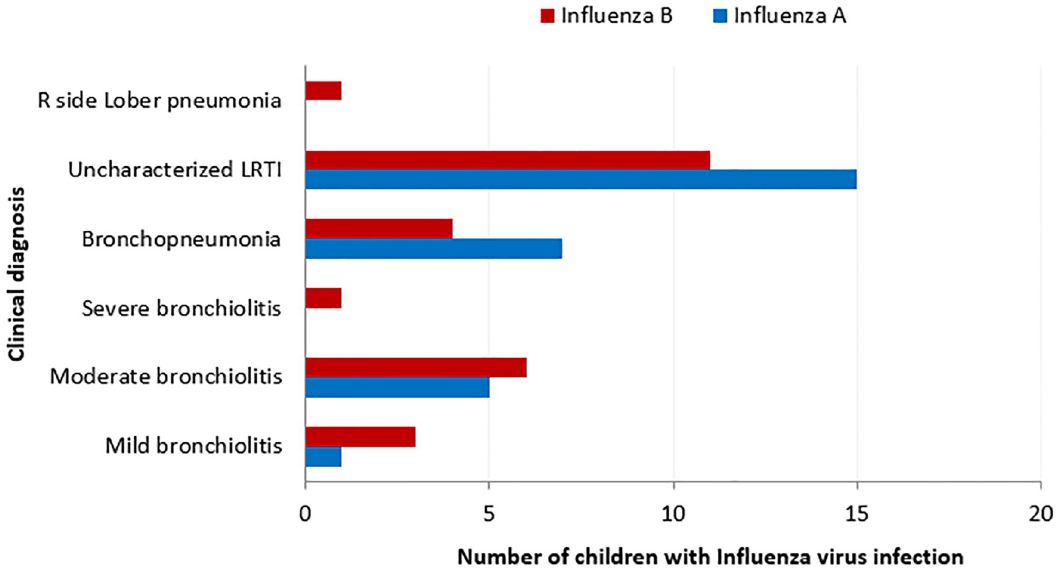
Fig 2. Clinical diagnosis of Inf-V associated ARI in children. Bronchiolitis is a common LRI and is due to the inflammation of the bronchioles it can be either mild, moderate or severe; Bronchopneumonia is pneumonia due to inflammation in the alveoli affecting bronchi and bronchioles; Uncharacterized lower respiratory infection is lower respiratory infection, which is not bronchiolitis or bronchopneumonia; Right side lobar pneumonia is inflammation in the lobes in the right